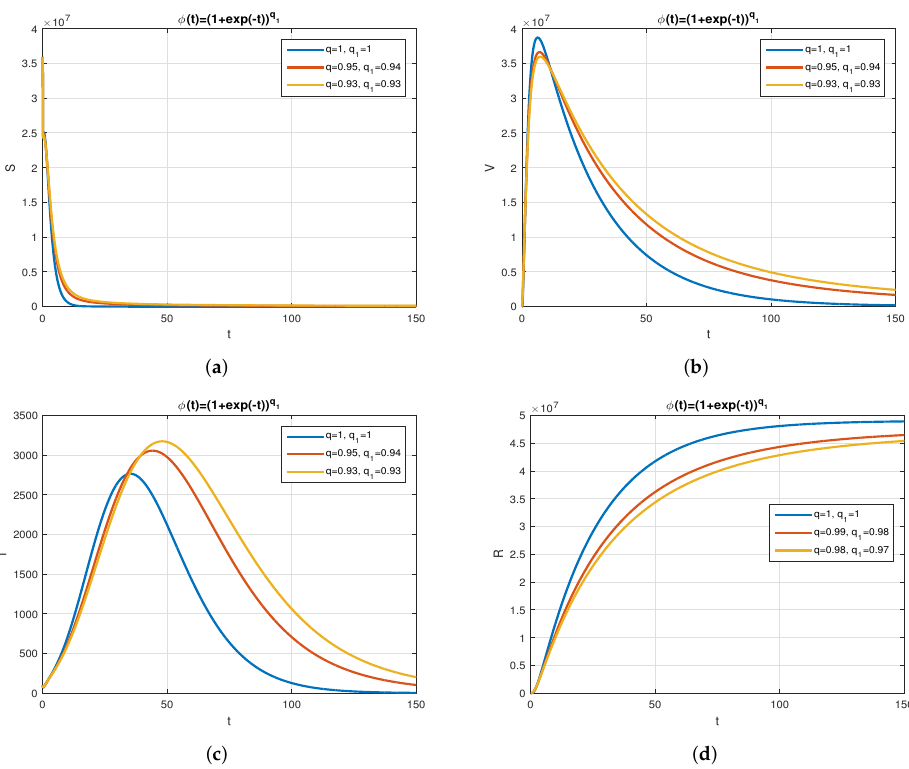
Figure 8. The behavior of the model for different values of q and q 1 with φ ( t ) = ( 1 + exp ( − t )) q 1 . Subfigure ( a ) shows the simulation of healthy population for various values of q and q 1 with φ ( t ) = ( 1 + exp ( − t )) q 1 . Subfigure ( b ) shows the simulation of vaccinated population for vari- ous values of q and q 1 with φ ( t ) = ( 1 + exp ( − t )) q 1 . Subfigure ( c ) shows the simulation of infected population for various values of q and q 1 with φ ( t ) = ( 1 + exp ( − t )) q 1 . Subfigure ( d ) shows the simulation of recovered population for various values of q and q 1 with φ ( t ) = ( 1 + exp ( − t )) q 1